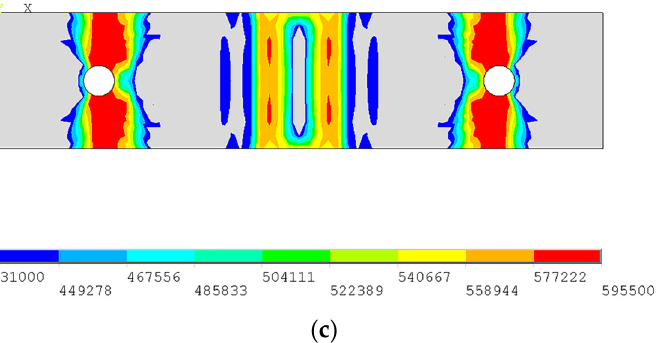
Figure 14. Stress distribution. ( a ) The first critical stress state, ( b ) The second critical stress state, ( c ) The limit state.